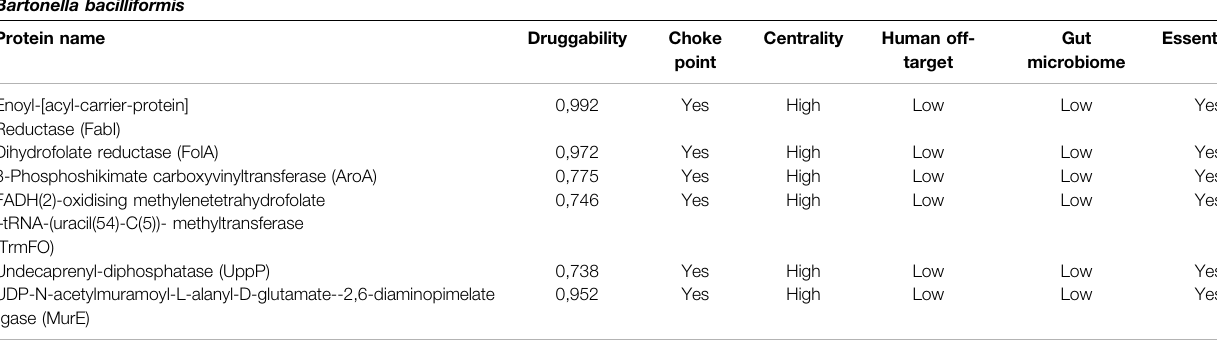
TABLE 1 | Proteins of Bb with desirable features to become a promising drug